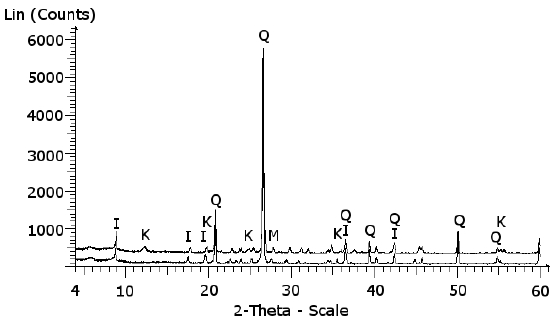
Figure 1. X-ray diffraction patterns of the PV-wf (upper) and PV-wf-a (lower). I = illite, K = kaolinite, Q = quartz, M 6= microline.